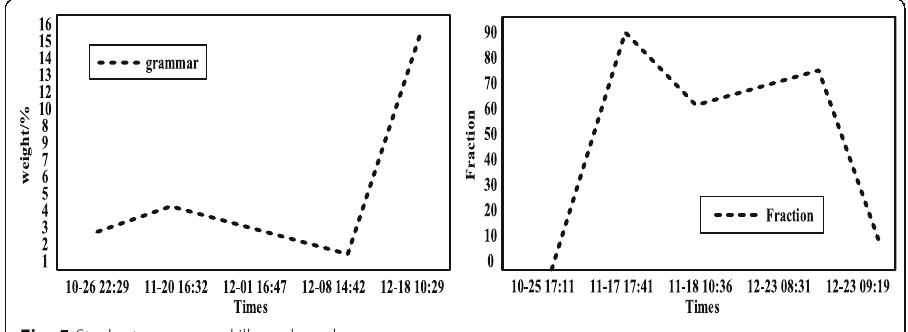
Fig. 5 Student grammar skills and